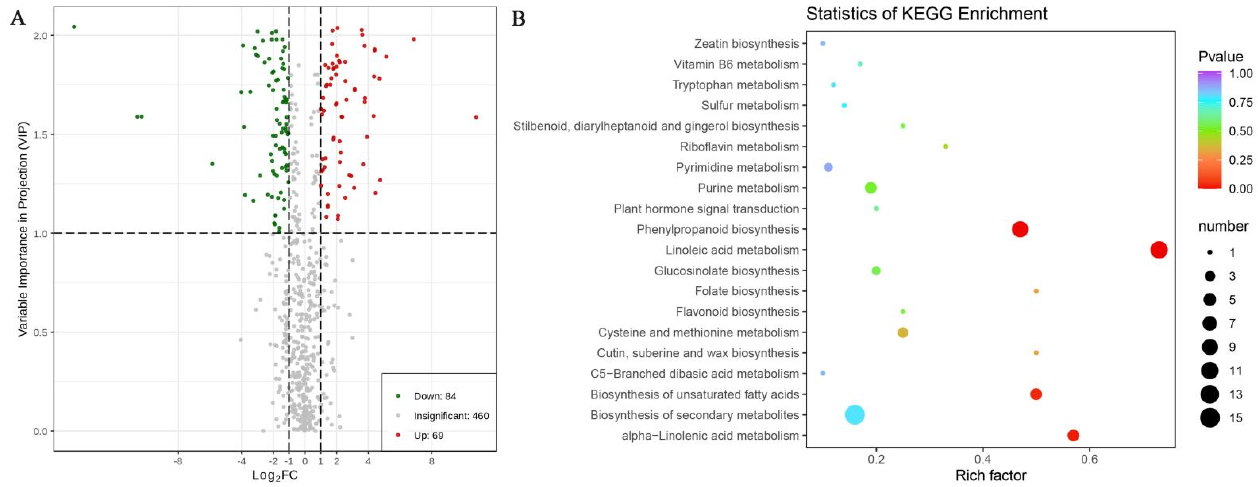
Figure 6. DAMs between G1 and G2. ( A ) The volcano plot shows the primary metabolites’ expression levels between G1 and G2. ( B ) Bubble diagram depicting the pathway analysis of the effects of storage on mulberry leaves’ metabolism.